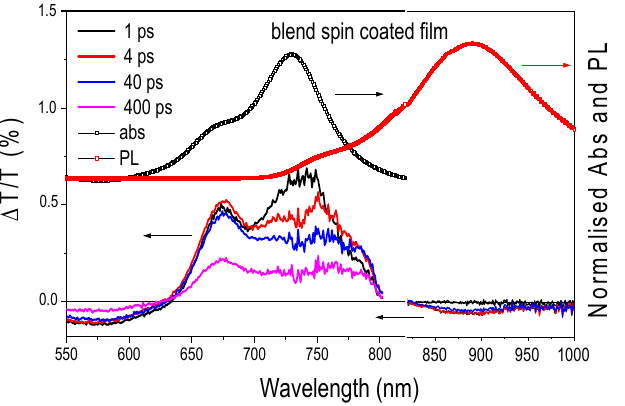
Figure 6. Absorption (black line + symbol) and PL (red line + symbol) spectra (translated vertically). Transient transmission spectra at different probe delays in the visible and NIR spectral regions.